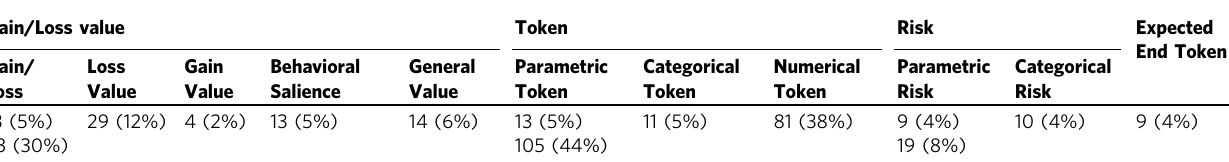
Table 2 Summary of the number and percentage of signi fi cant responding neurons in different subsets of neuron types for all recorded AIC